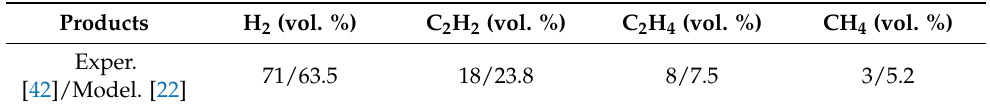
Table 4. Contents of stationary concentration of main gas products of microwave discharge in liquid n -heptane obtained in experiment [42] and modeling